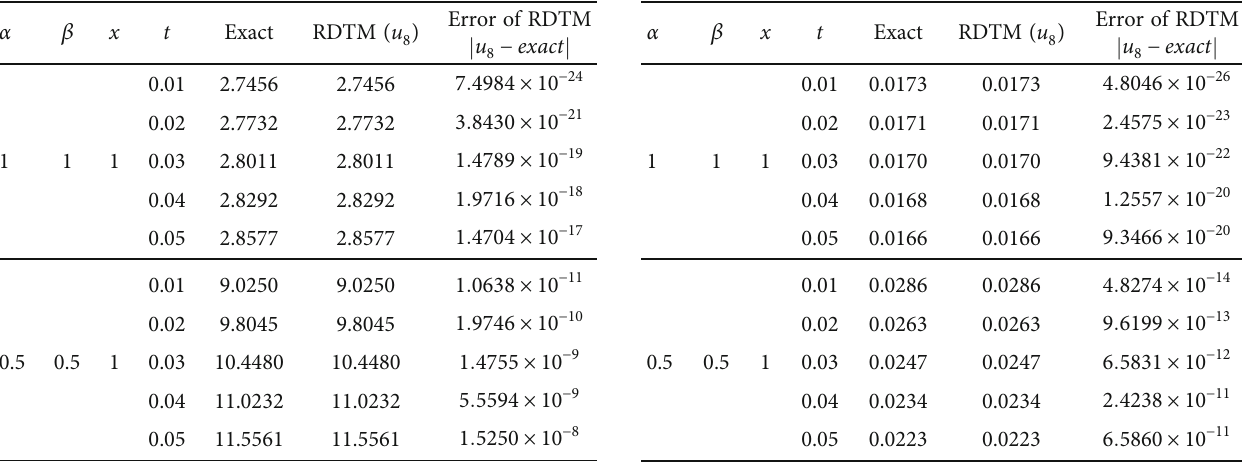
Table 1: Eighth-order approximate solution by RDTM of Example 1 for di ff erent values of α , β , and t and comparison with the exact solution.